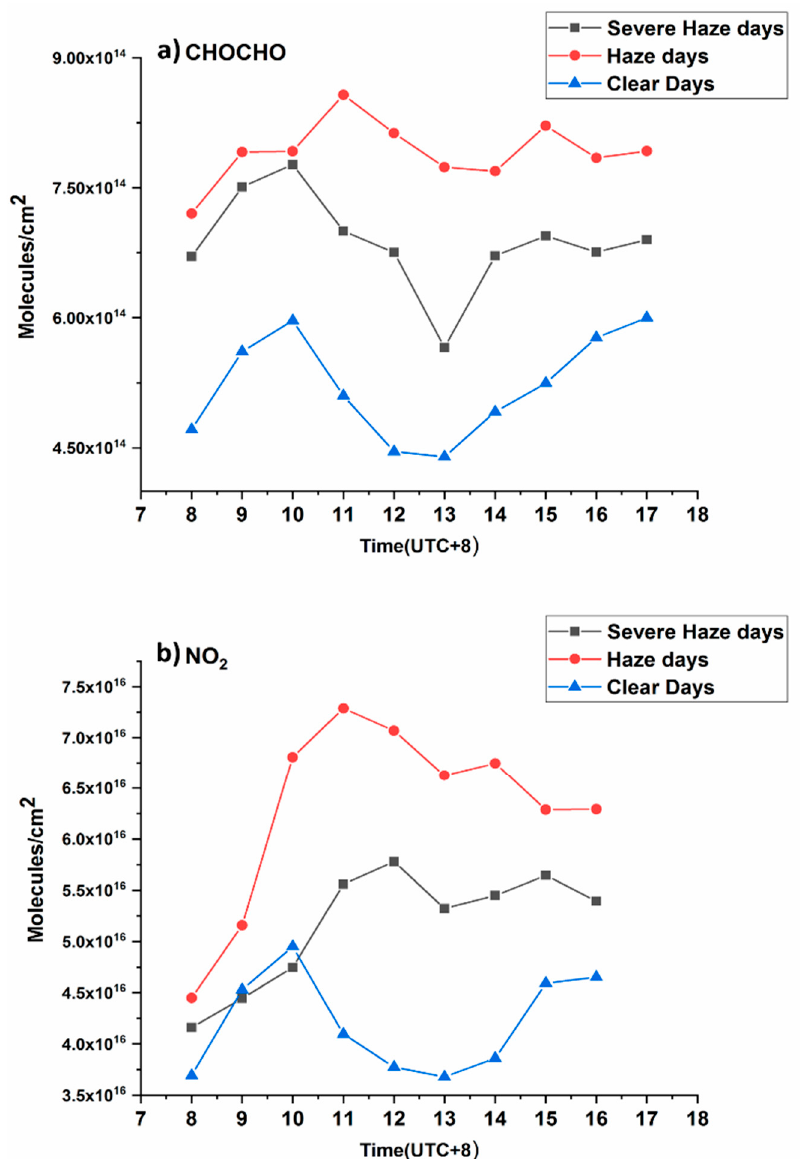
Figure 7. Diurnal cycles for ( a ) CHOCHO and ( b ) NO 2 VCDs monitored in Hefei, China.